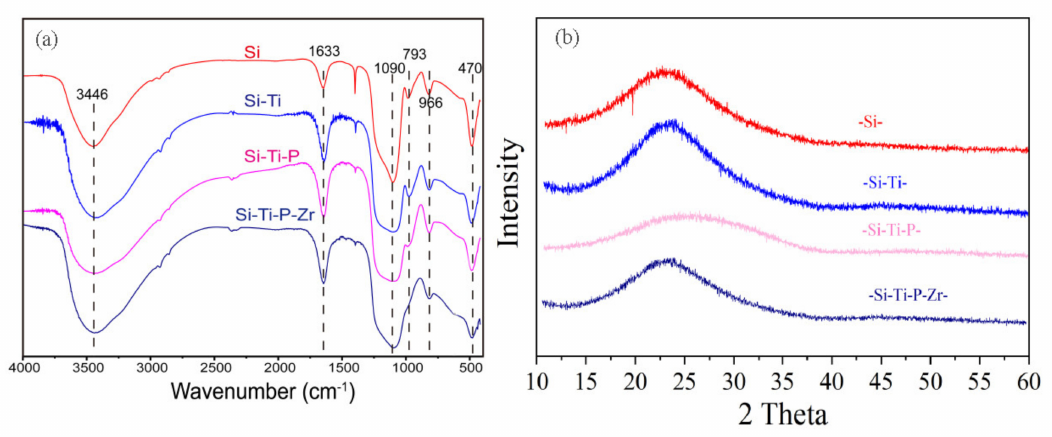
Figure 3. The ( a ) FT-IR and ( b ) XRD analysis of the formation process of the adsorbent (SBA-15, Si-Ti, Si-Ti-P, and